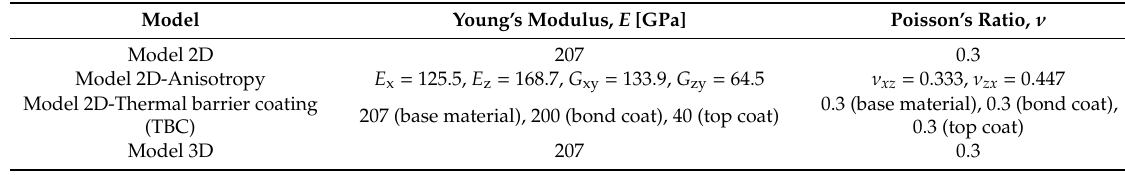
Table 1. Material properties of the four types of models.